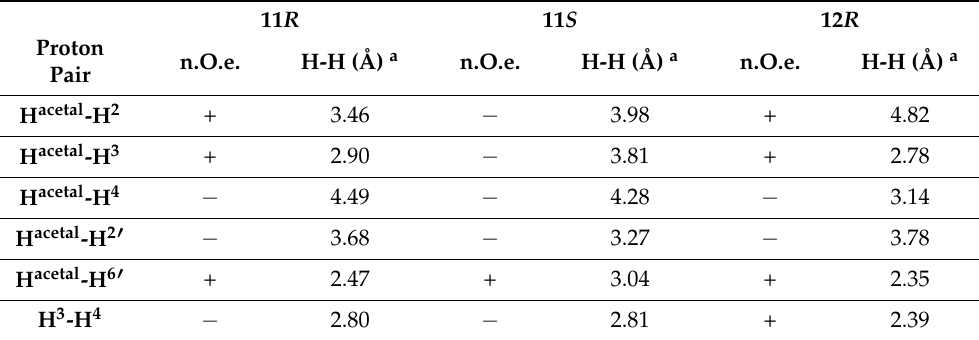
Table 4. Experimentally observed n.O.e. and H-H calculated distances for compounds 11 R , 11 S , and 12 R . 11 R Proton